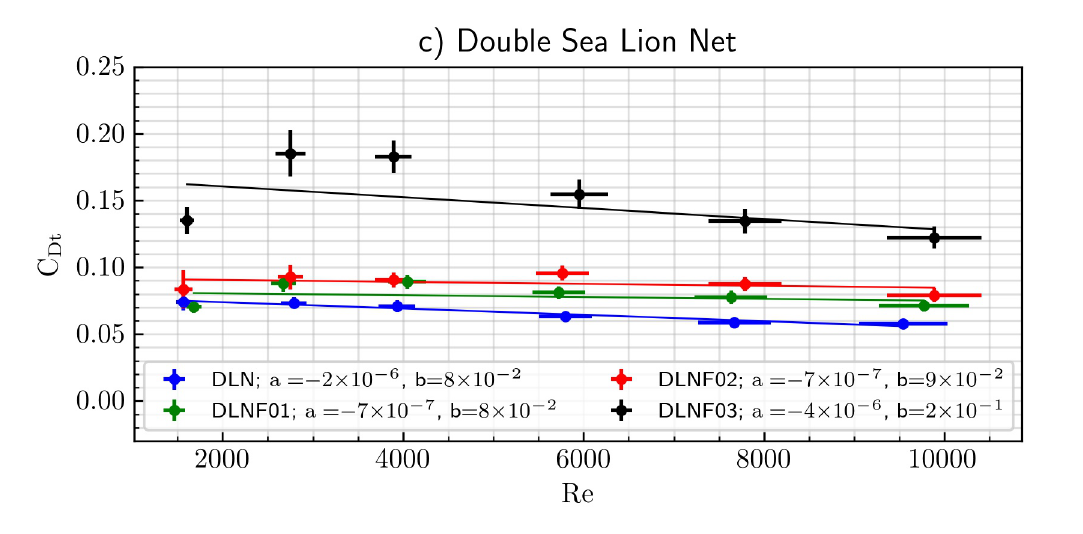
Figure 8. Experimental results of the tangential drag coefficient for fish and sea lion nets as a function of the Reynolds number. Experimental series, clean or without fouling, from Table 1. Lines represent linear fits of the data.